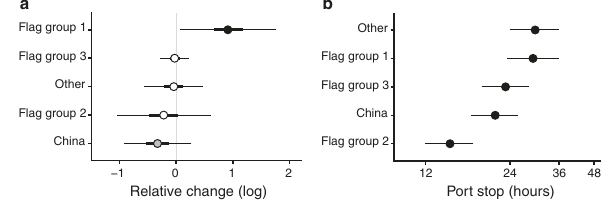
Fig. 6 Vessel behavior related to Port State Measures Agreement (PSMA) entry into force and port duration. ( a ) Relative changes in the number of visits by foreign vessels to PSMA parties by fl ag group for fi shing vessels between 2015 (pre-PSMA) and 2017 (post entry into force). Points are medians of Bayesian posteriors, and thin and thick horizontal lines are 95% and 50% credible intervals (CIs), respectively. Vertical line at 0 indicates no change. Black points indicate 95% CIs that do not overlap with zero, gray points indicate 50% CIs do not overlap with zero, and white points indicate overlap. ( b ) Port stop duration by fl ag group for fi shing vessels, using gear type and port state as random effects. Points and horizontal lines represent the best estimates and 95% con fi dence intervals, respectively. See Fig. 3 for fl ag group descriptions and Supplementary Table 2 for countries associated with different fl ag